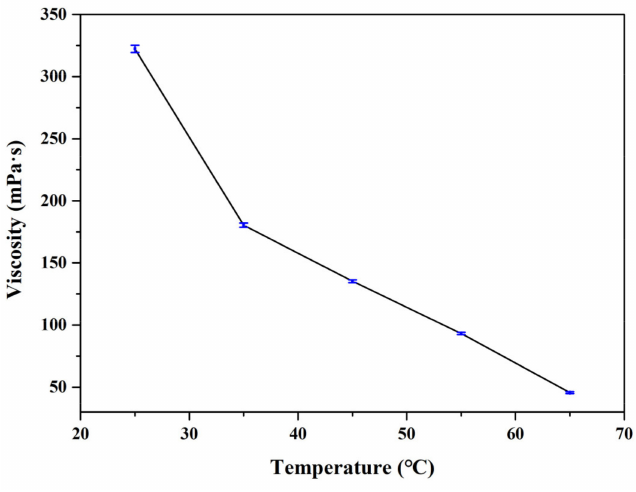
Figure 2. The resin viscosity at different